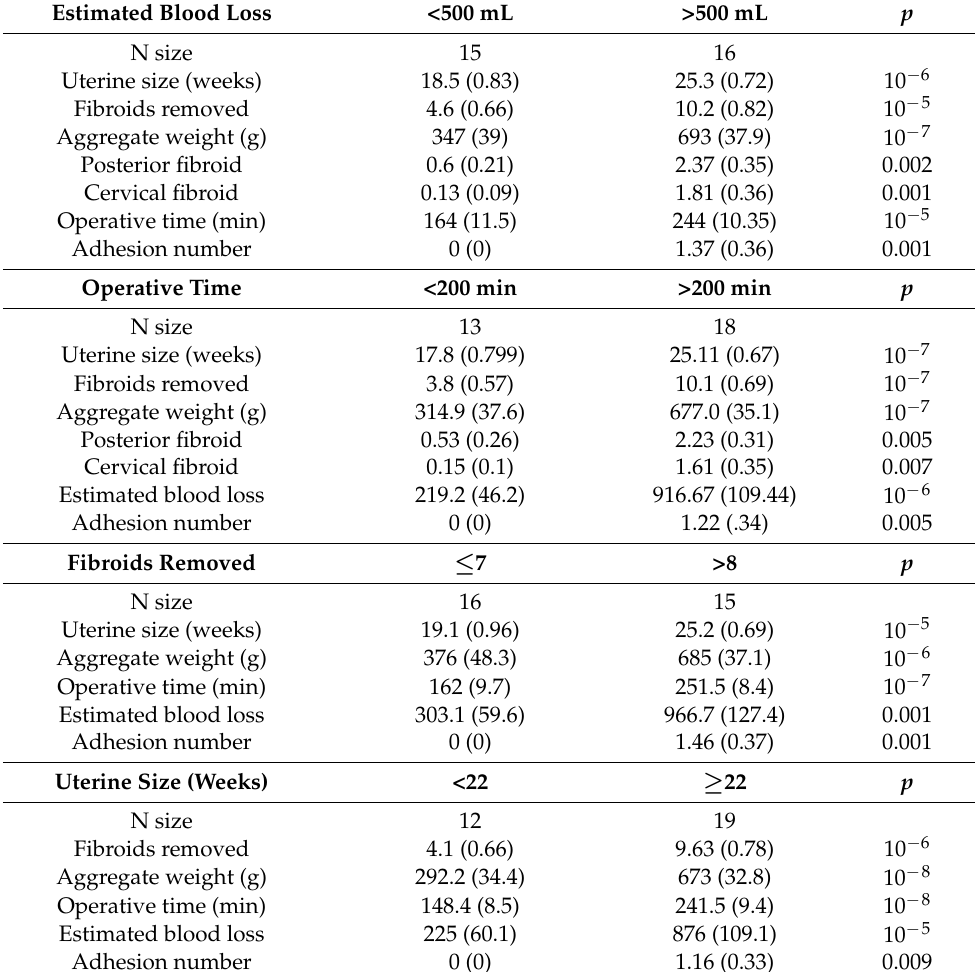
Table 3. Effectiveness of the intervention by stratified group. Stratifying the study group, the intervention was particularly effective at preventing adhesion formation when estimated blood loss, operative time, number of fibroids removed, and uterine size were smaller. Mean (standard error of the mean) and significance are